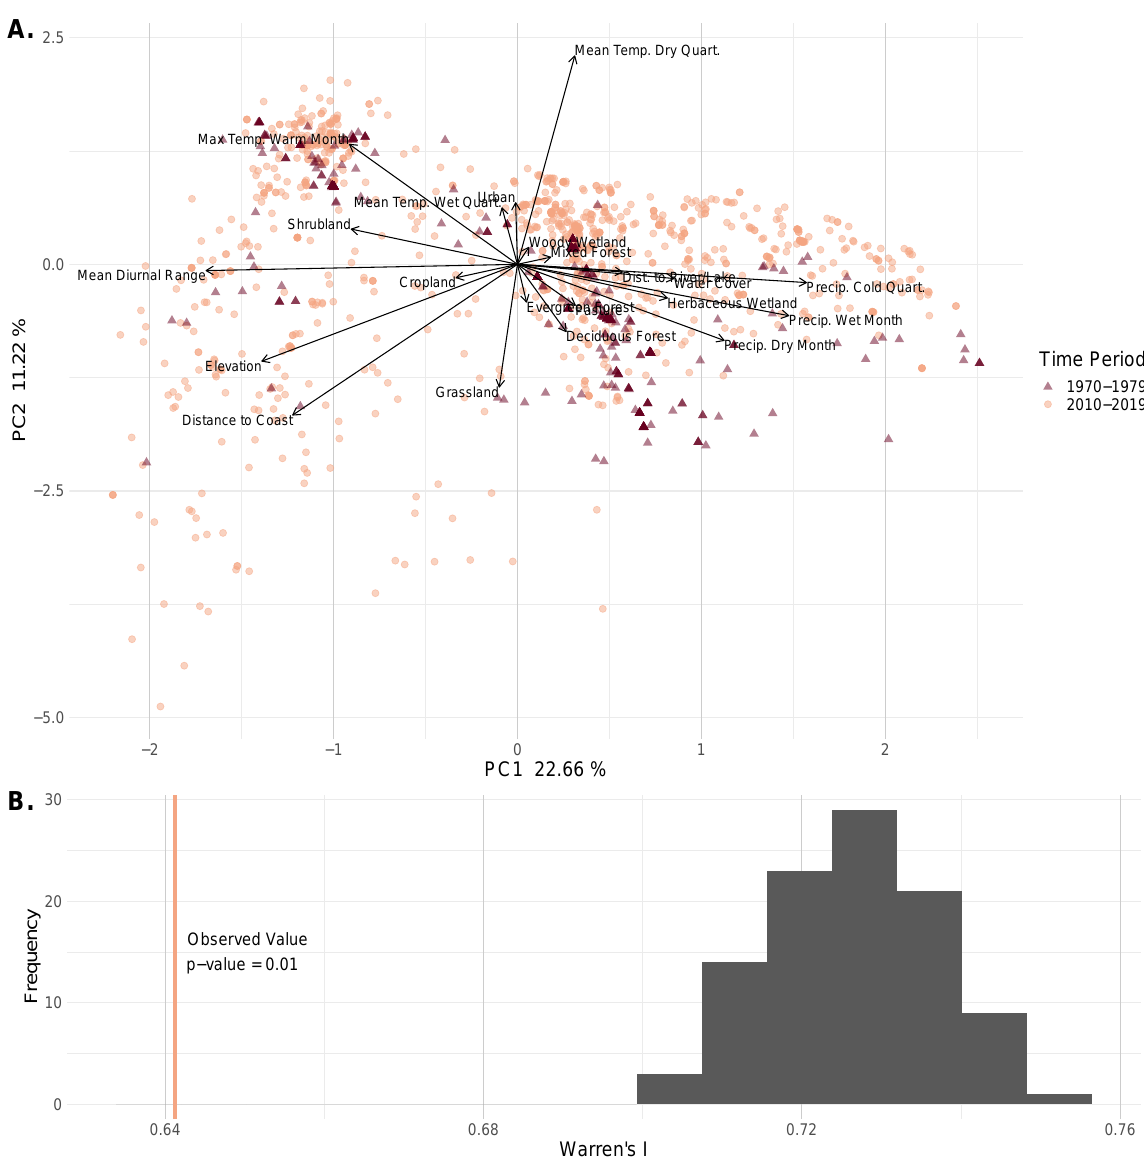
Supplementary Figure 5 – Results of the niche similarity test between the historic (1970-1979) and current (2010-2019) time periods for the great-tailed grackle. (A) Species occurrence points plotted along the first two principal component (PC) axes used for the niche similarity test. The percent variance captured by each principal component is presented in the axis label. The black lines expanding from the origin indicate the rotation values for the environmental predictors along the two principal components. The current time period observations were randomly subsampled to 1000 points for visual clarity. (B) Values of Warren’s I from the niche similarity test based on the observed data (solid line) and 100 simulations (histogram). Higher values of Warren’s I indicate greater niche similarity. The p-value presented for the observed value is based on the null hypoth- esis that the observed value presents equal or greater niche similarity than the